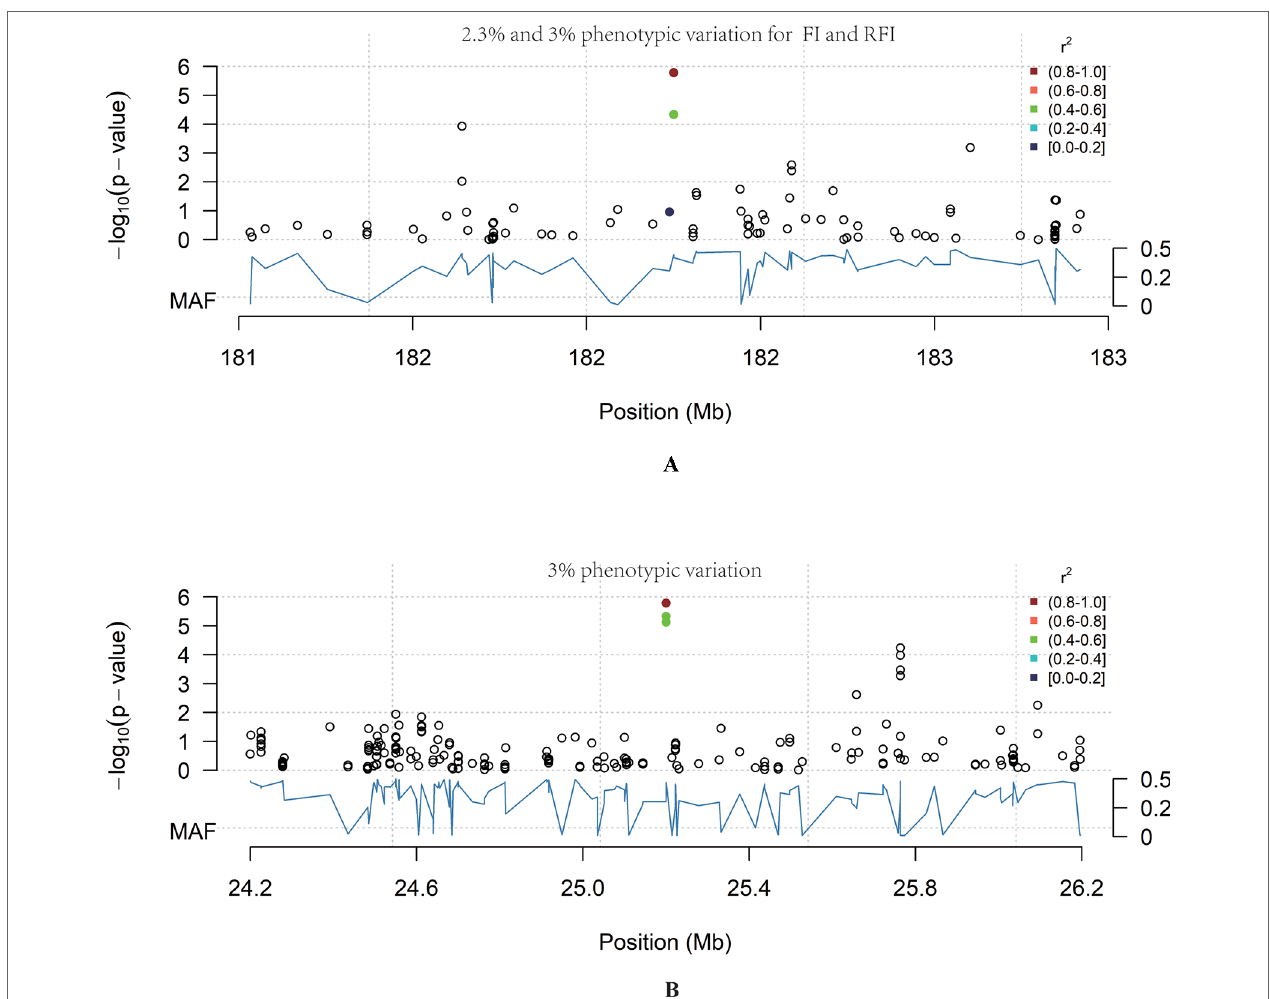
FIGURE 2 | The genome-wide significant loci. The blue curve represents the minor allele frequency; the point colour represents the linkage coefficient between the most significant point and other loci, with red being the highest. (A) Chr6: 24–26 Mb region. In this region chr6: 25158157_A>T was significantly associated with FCR ( P = 1.65E-06). (B) Chr1:181–183 Mb region. In this region Chr1: 182200072_C>T was significantly associated with RFI ( P = 1.65E-06).